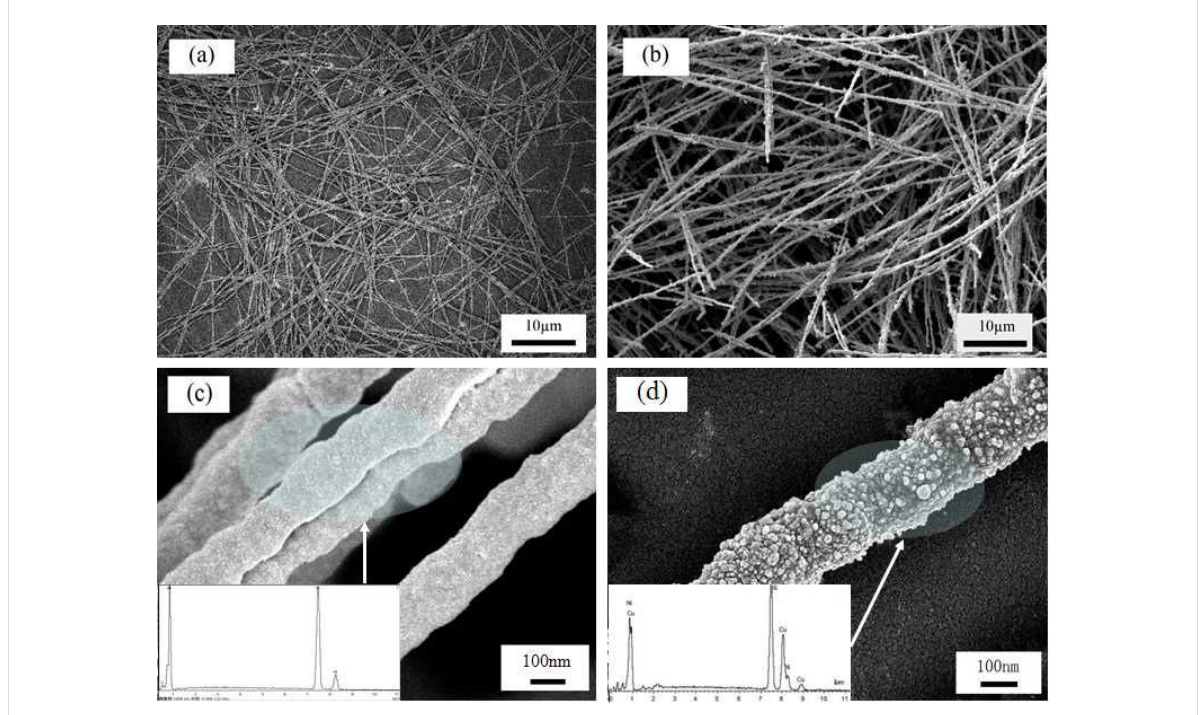
Figure 1: SEM images of Ni nanowires under different magnification (a,c) and Ni/Cu composite nanowires under different magnification (b,d), insets (c,d) are EDS images of Ni nanowires and Ni/Cu composite